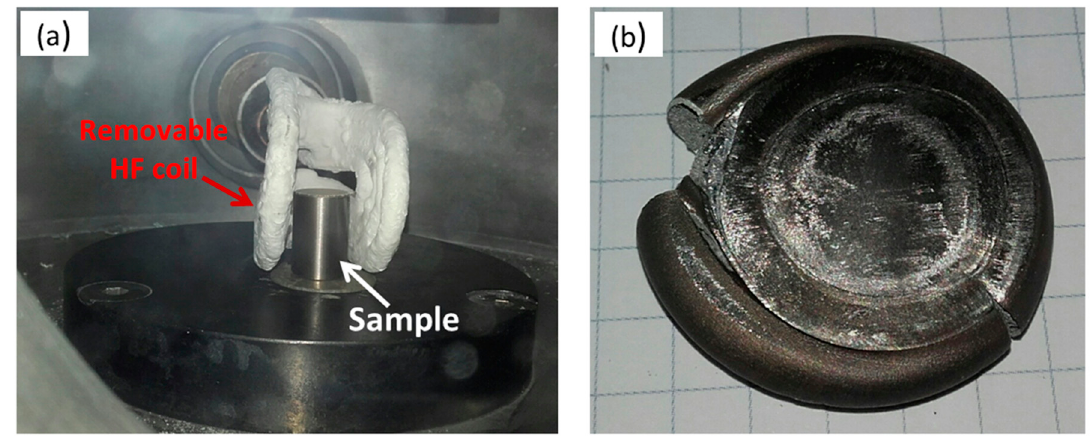
Figure 1. ( a ) Internal part of the forging chamber, with a sample into the high-frequency heating coil; ( b ) pure magnesium sample forged at room temperature.